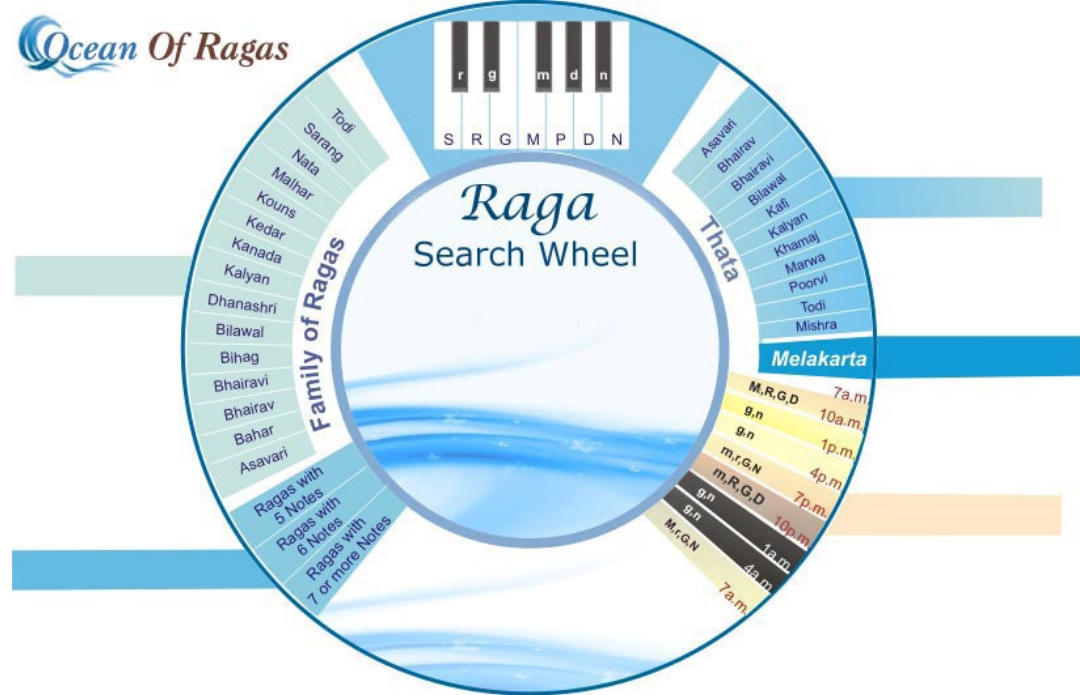
Figure 1. Raga Search Wheel (http://oceanofragas.com/Raga_search_wheel.aspx, accessed on 6 December 2021).